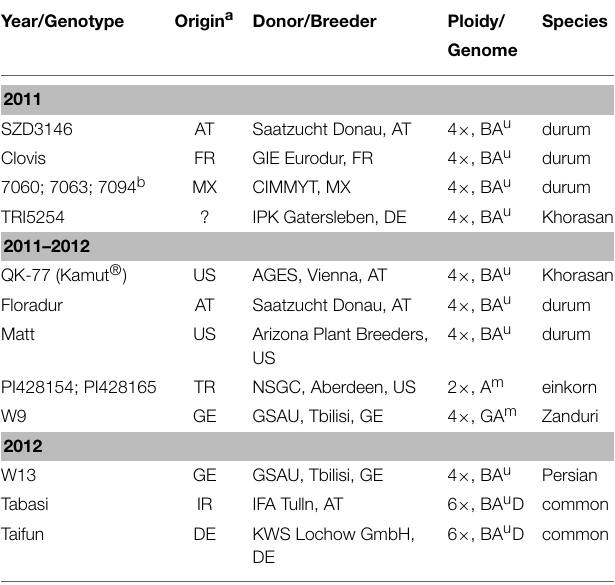
TABLE 1 | Characteristics and origin of the wheat germplasm used in the experiment.